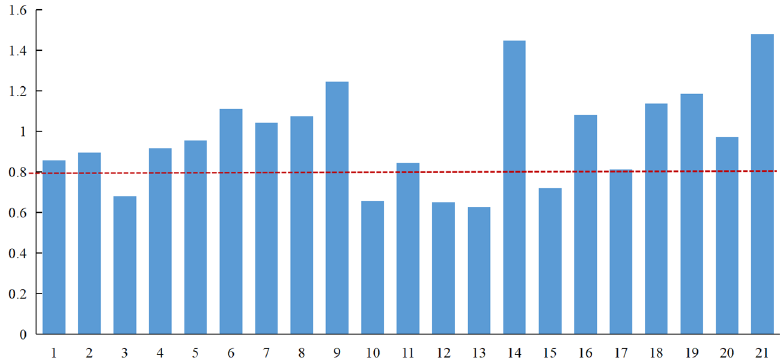
Figure 8. VIP values of factors affecting changes in disaster resilience.